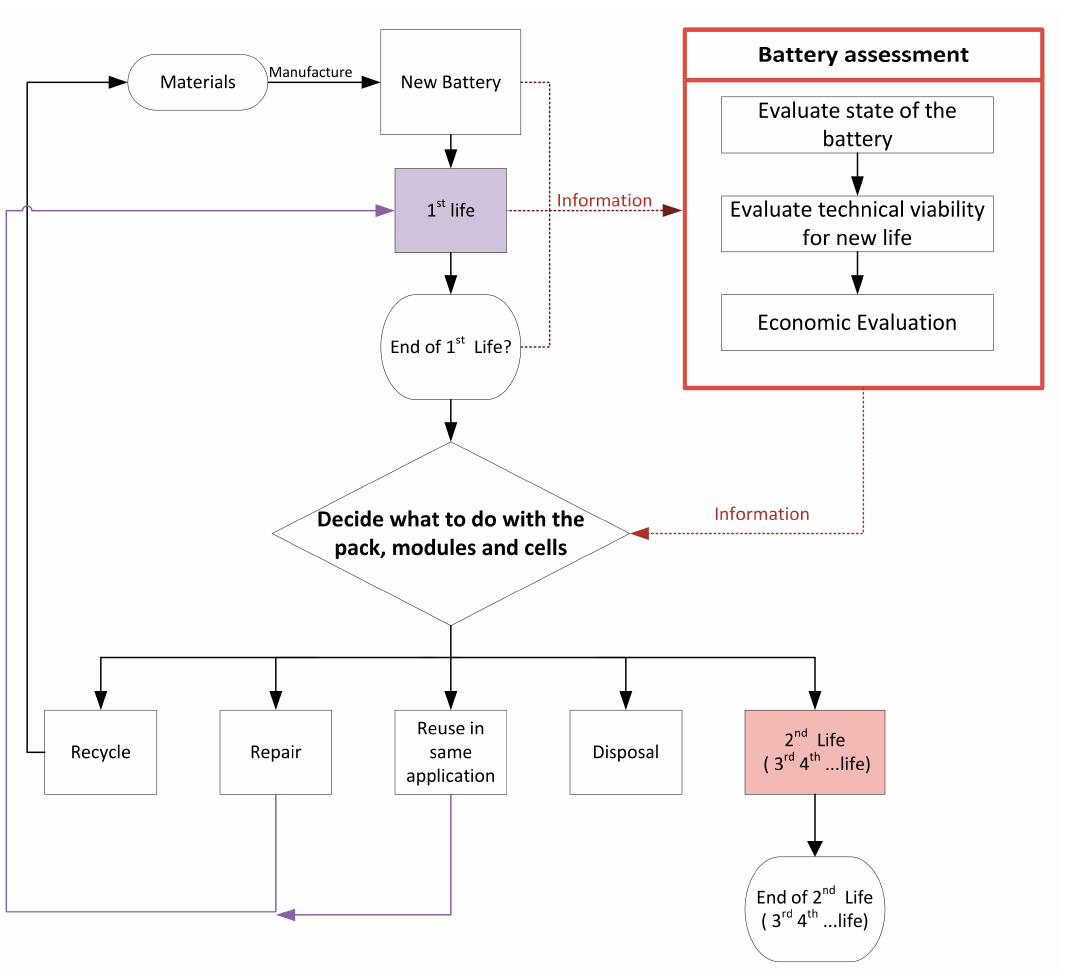
Figure 1. The proposed battery assessment as part of a simplified battery life